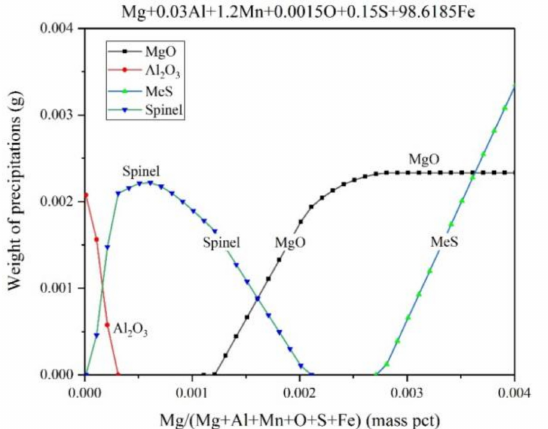
Figure 7. Effect of magnesium addition on the evolution of inclusions after sulfur addition (MeS: Mg 0.9 Mn 0.1 S, Spinel: MgAl 2 O 4 ).